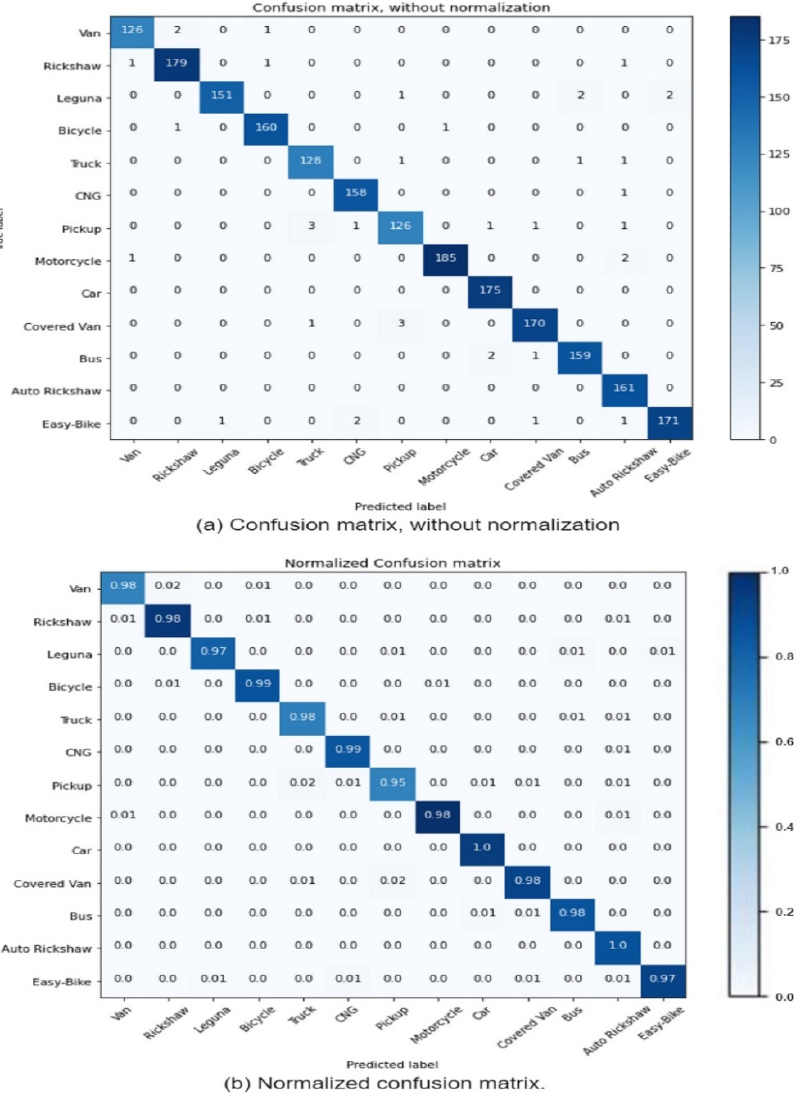
Figure 10. Confusion matrix for Deshi-BD native vehicle dataset; ( a ) confusion matrix, without normalization, and ( b ) normalized confusion matrix.